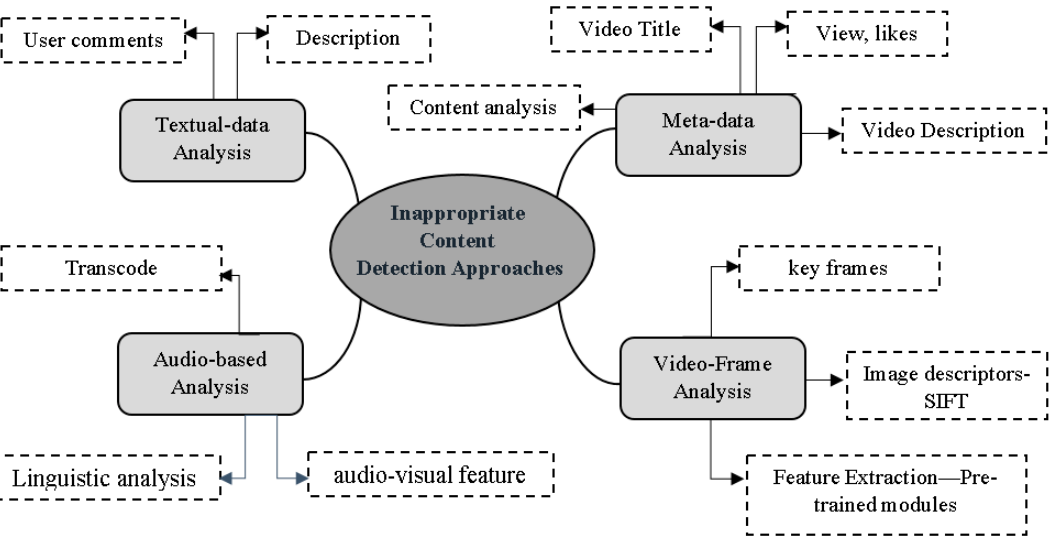
Figure 4. An overview of existing methods for preventing inappropriate content on YouTube video